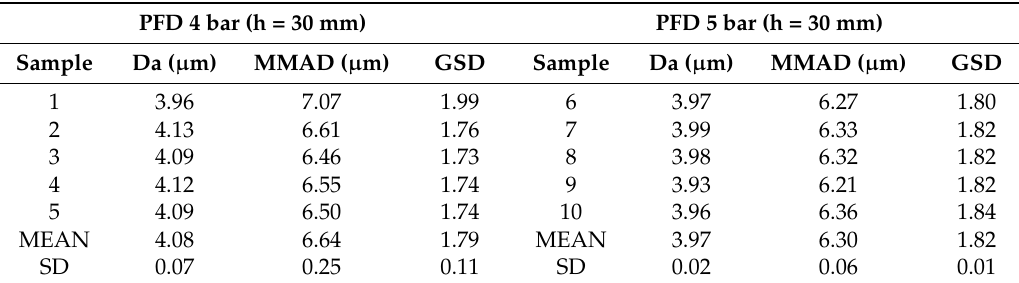
Table 1. Perfluorodecalin (PFD) experimental results at h = 30 mm.